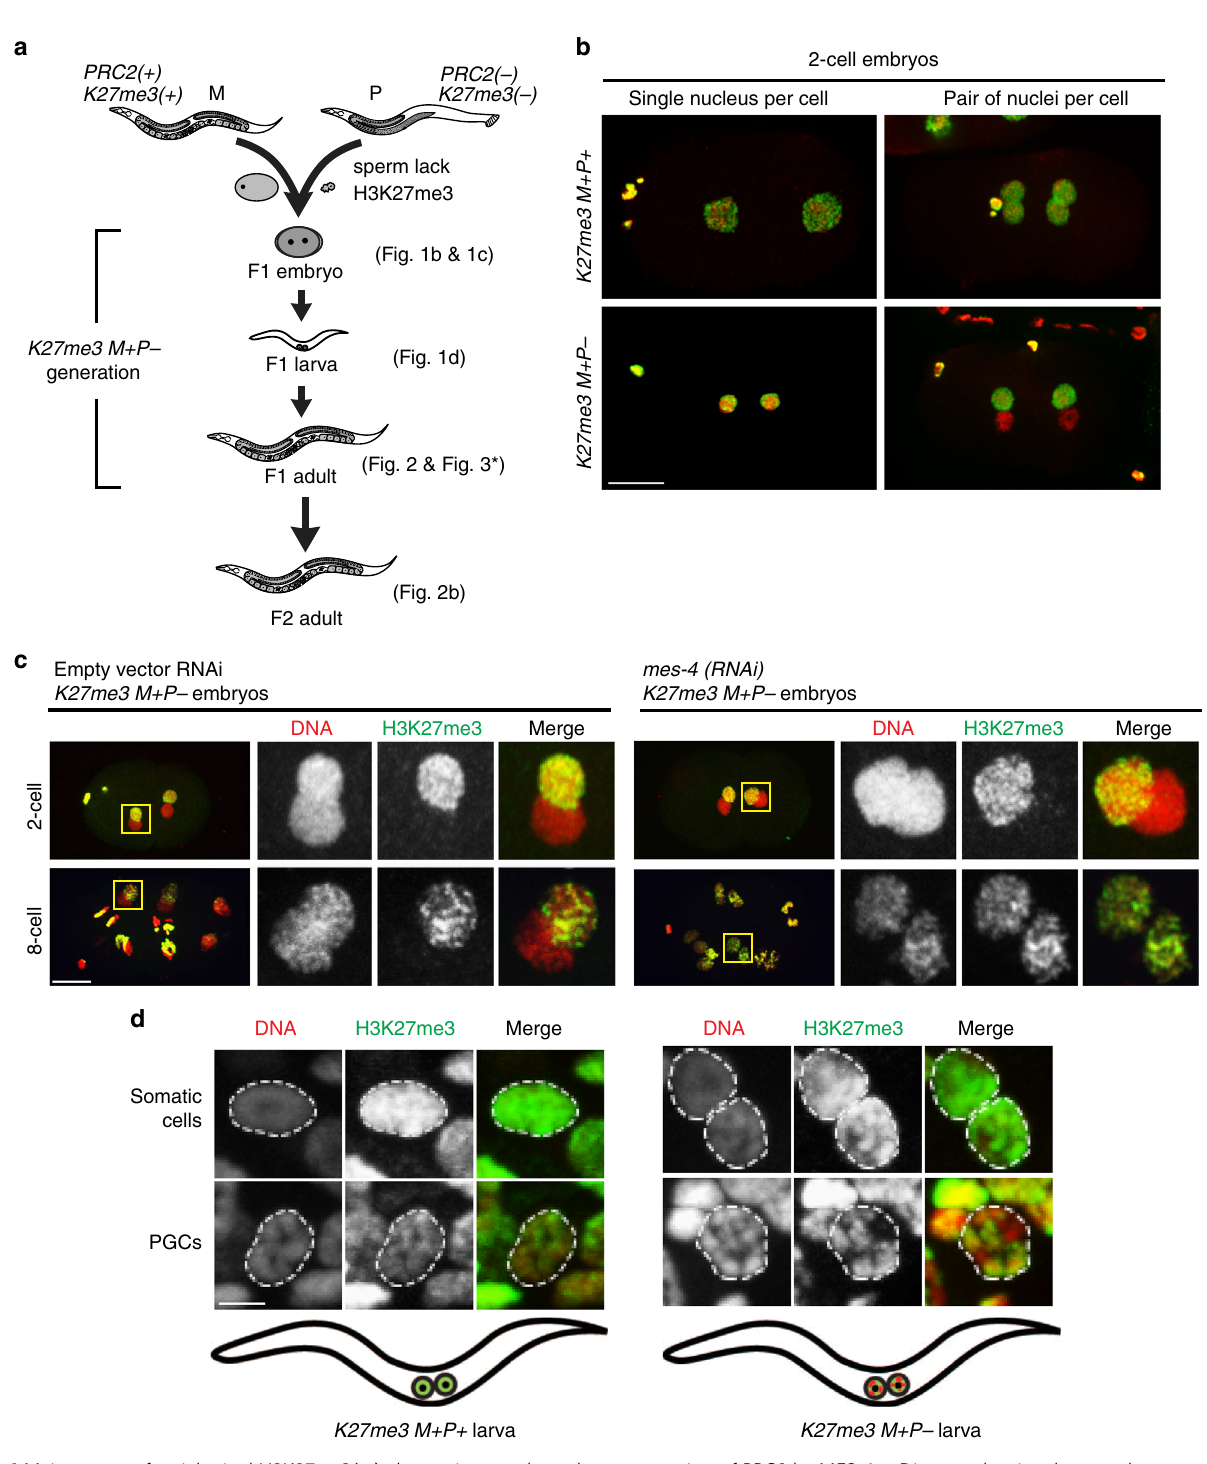
Fig. 1 Maintenance of an inherited H3K27me3( − ) chromatin state depends on antagonism of PRC2 by MES-4. a Diagram showing the cross between wild- type PRC2( + ) K27me3( + ) females and mes-3/mes-3 PRC2( − ) K27me3( − ) males that generates K27me3 M + P − F1 offspring. Maternal and paternal pronuclei are shown in the F1 1-cell embryo. The 2 primordial germ cells (PGCs) are shown in the newly hatched F1 larva. F1 hermaphrodites self-cross to produce F2 offspring. Figures that analyzed each generation/stage are indicated in parentheses. M, maternal; P, paternal; *Sensitized genetic background. Hybrid F1s were generated by mating Hawaii mothers with Bristol fathers. b Images of wild-type 2-cell embryos (left panels) or plk-1 2-cell embryos (right panels) demonstrate that the H3K27me3( − ) state of sperm chromosomes in K27me3 M + P − embryos (bottom panels) is easily monitored when sperm- and oocyte- inherited chromosomes are kept in separate nuclei in plk-1 mutants. DAPI-stained DNA in red. H3K27me3 immunostaining in green. Scale bar represents 10 μ m. c 2-cell and 8-cell stage K27me3 M + P − embryos whose mothers were fed empty vector RNAi (control) or mes-4(RNAi) to knock down the maternal load of MES-4. DAPI-stained DNA in red. H3K27me3 immunostaining in green. Regions boxed in yellow in the left panels are shown at higher magni fi cation in the right panels. Scale bar represents 10 μ m. d Somatic cells and PGCs in a K27me3 M + P + L1 (left) and a K27me3 M + P − L1 (right). L1 schematics show the observed staining pattern in PGCs for each genotype. DAPI-stained DNA in red. H3K27me3 immunostaining in green. Scale bar represents 2 μ m NATURE COMMUNICATIONS| (2019) 10:1271